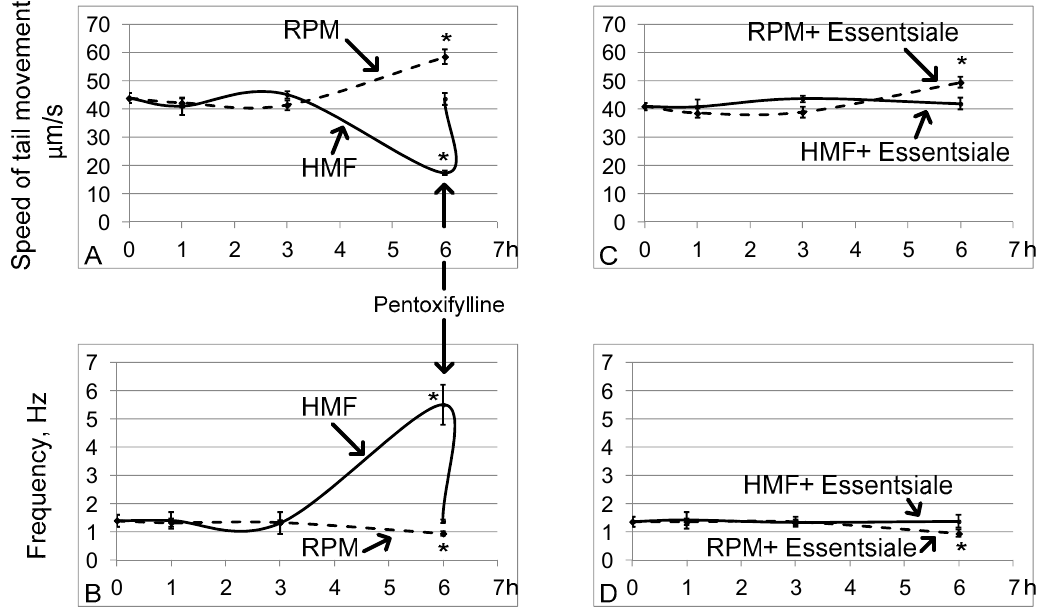
Figure 1. The speed of movement of the end of the tail of the sperm and its frequency. The solid line shows the changes in hypomagnetic conditions, and the dashed line shows the microgravity simulation using random position machine. * p < 0.05 compared with the control group C. ( A , B ) are the speed of movement and frequency, respectively, without oral administration of essential phospholipids. The arrow shows that the addition of pentoxifylline at a dilution of 1:2.5 leads to an increase in the speed of movement and a decrease in the frequency of beating of the end of the tail of the sperm after a 6-h exposure under hypomagnetic conditions. ( C , D ) are similar parameters (as in ( A , B )) but with the oral administration of essential phospholipids.